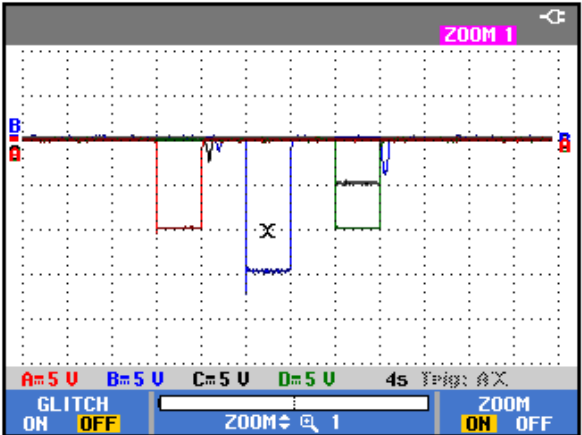
Figure 21. Mitigation signals during mixed voltage attacks.